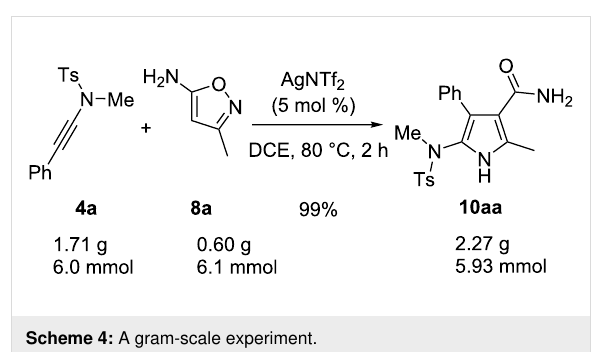
Scheme 4: A gram-scale